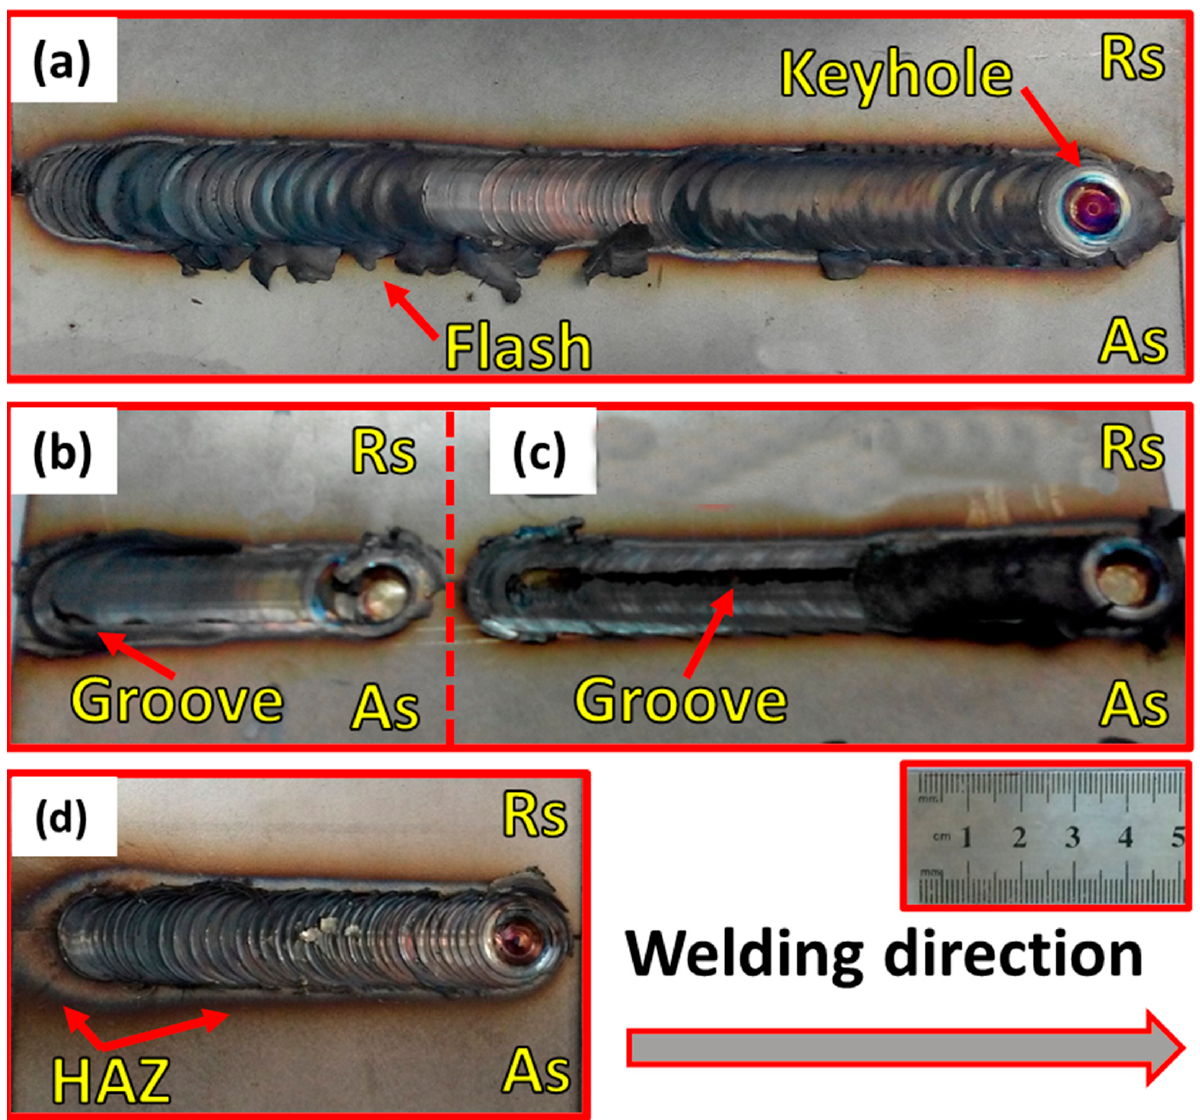
Figure 3. Top view appearance of 2205 DSS FSWed butt joints at welding parameters of ( a ) 600 rpm, 50 mm/min, and 14 kN, ( b ) 300 rpm, 50 mm/min, and 14 kN, ( c ) 300 rpm, 25 mm/min, and 14 kN, and ( d ) 300 rpm, 25 mm/min, and 20 kN. Table 4. Visual Inspections for the FSWed 2205 DSS Butt Welds. Surface Defect Specimen No. Figure Visual Appearance Test Results Flash Groove Figure 3a Good much Non Accepted Figure 3b Partially good Small Detected Rejected Figure 3c Bad Small Detected Rejected S4 Figure 3d Very good Very small Non